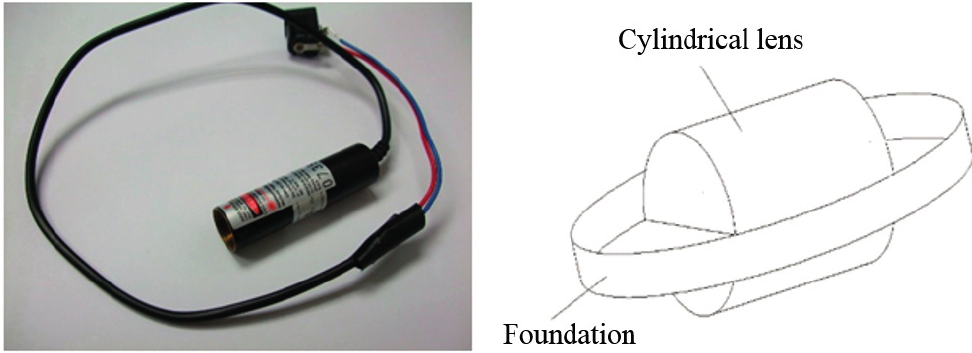
Figure 7. Red line Laser Diode Module and a schematic showing the cylindrical lens.